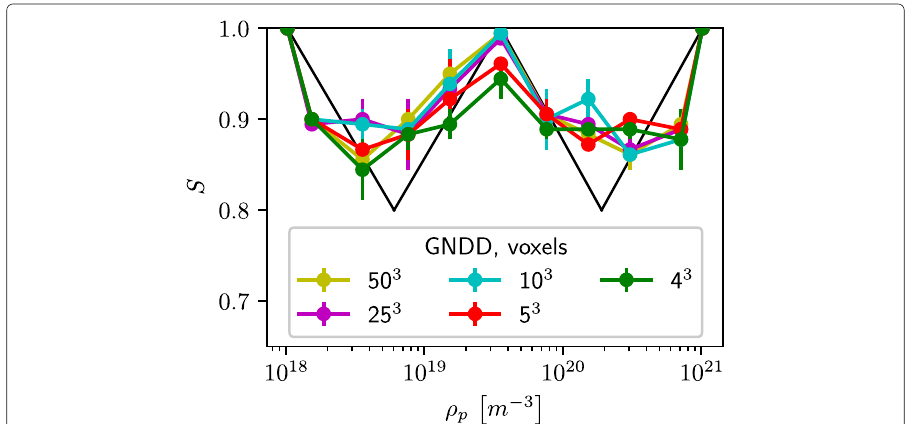
Fig. 9 Confusion curve dependency on the number of GND density voxels. Only slight decrease of the maximum in the curve is observed depending on the number of voxels (i.e. voxel size from 280 b to 3500 b ) when measuring GND